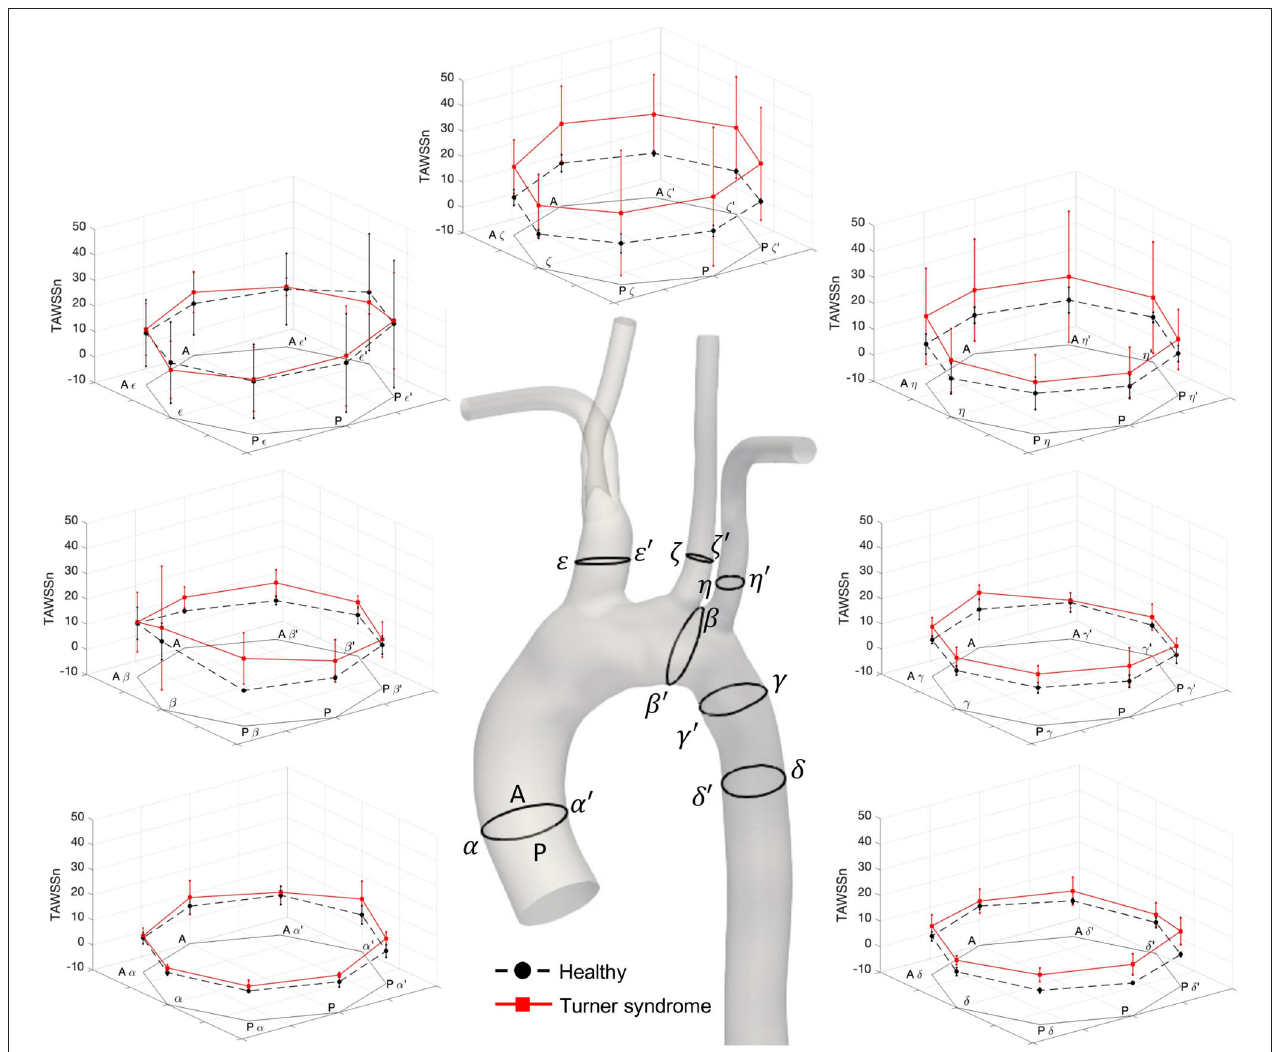
FIGURE 8 | Normalized time-averaged wall shear stress (TAWSS n ) values at seven cross-sections along the aorta of the healthy (black, dotted lines, as average of H1–H3) and Turner syndrome girls (red, solid lines, as average of TS1–TS4). Cross-sections are located as shown on the 3D model of a healthy (H1) case. Standard deviation shown as error bars at each